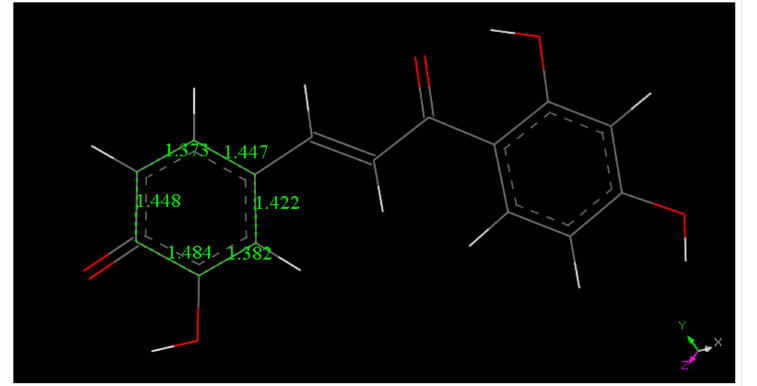
Figure 9. After elimination of O 2 H from Figure 8, the semiquinone Butein radical structure is geometry optimized. Comparison with Figure 7 shows aromatization loss due to the double bond character of the newly formed